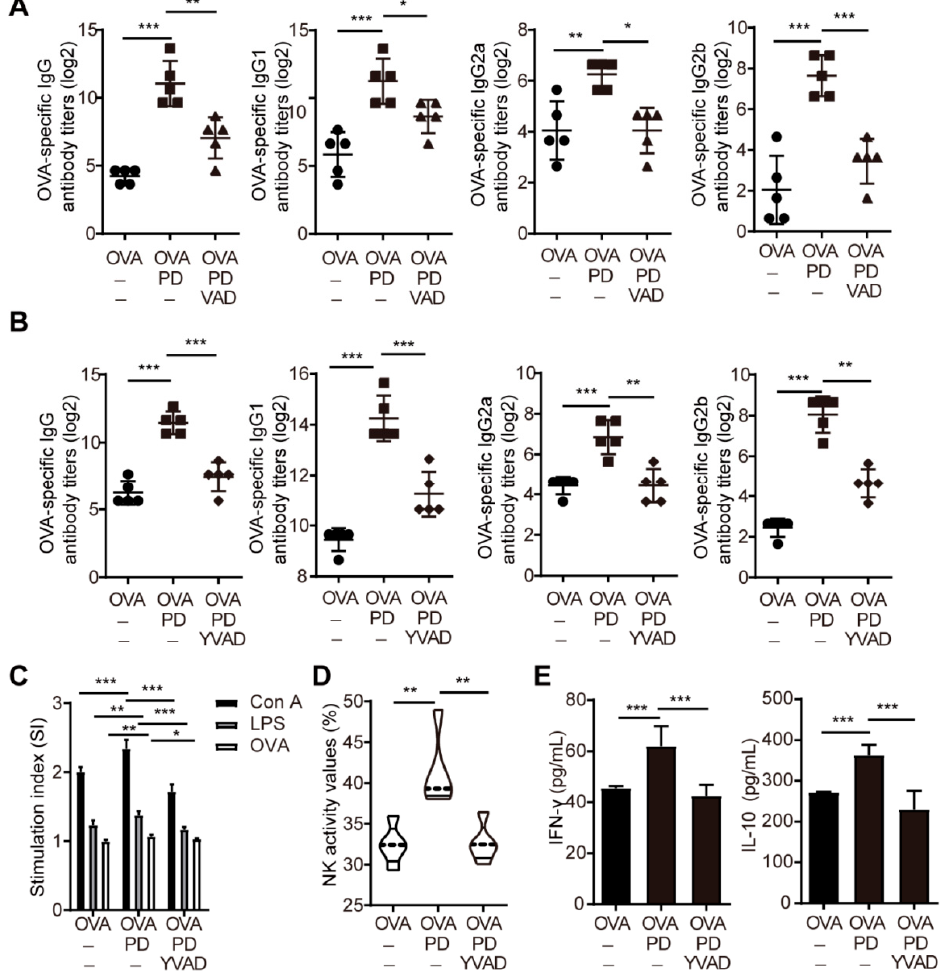
Figure 8. Caspase-1 mediated the adjuvant activity of PD. ( A , B ) Mice were injected i.m. with z-VAD-FMK ( A ) or Ac-YVAD-CMK ( B ) at the dose of 1 μ g/g for 1 h before immunization. Sera were